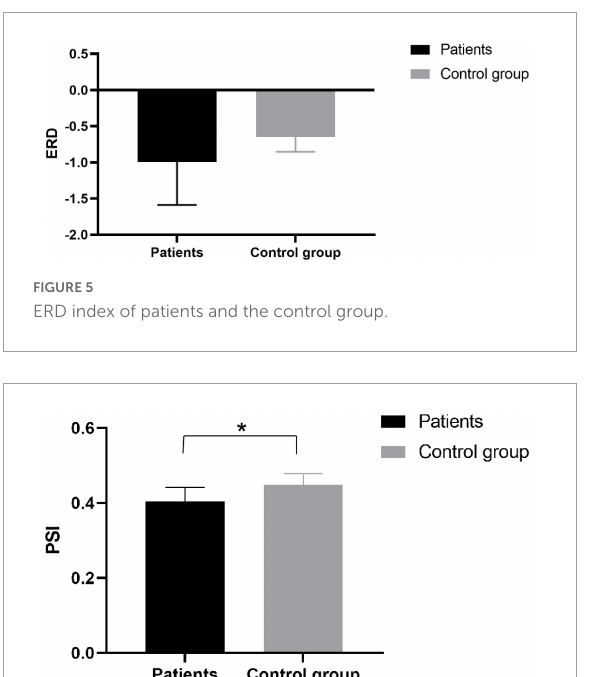
FIGURE6 PSI index of patients and the control group. *Significant difference.